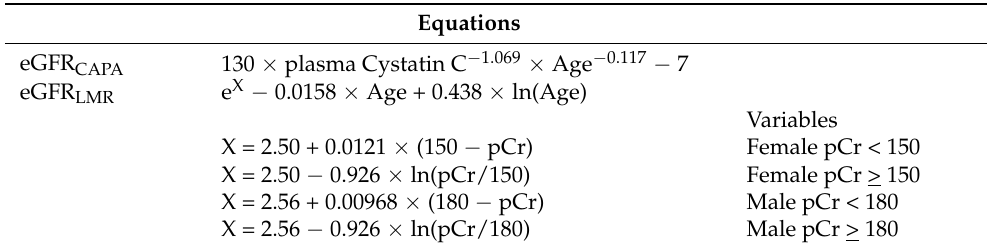
Table 1. Equations used to estimate glomerular filtration rate (eGFR) by cystatin C and creatinine. Both equations depend on age, whereas LMR also depends on gender. pCr is the plasma creati- nine